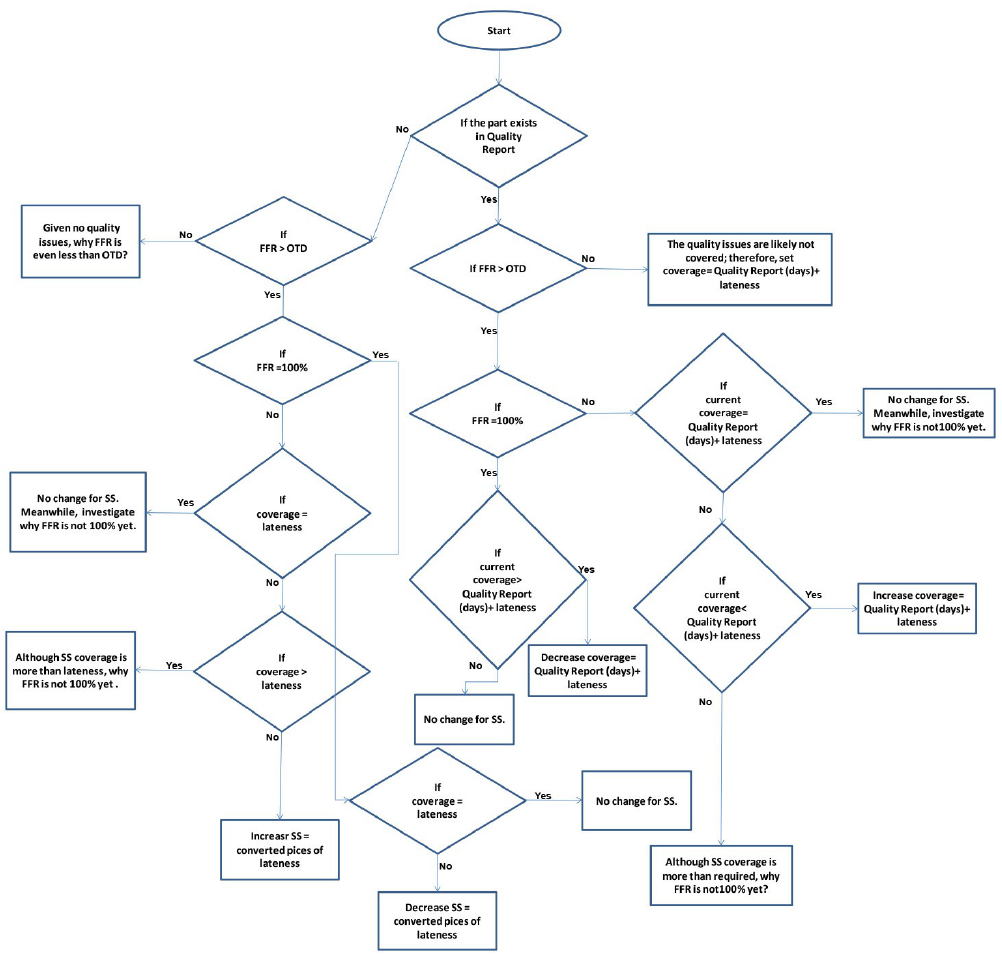
Figure 11. Red area